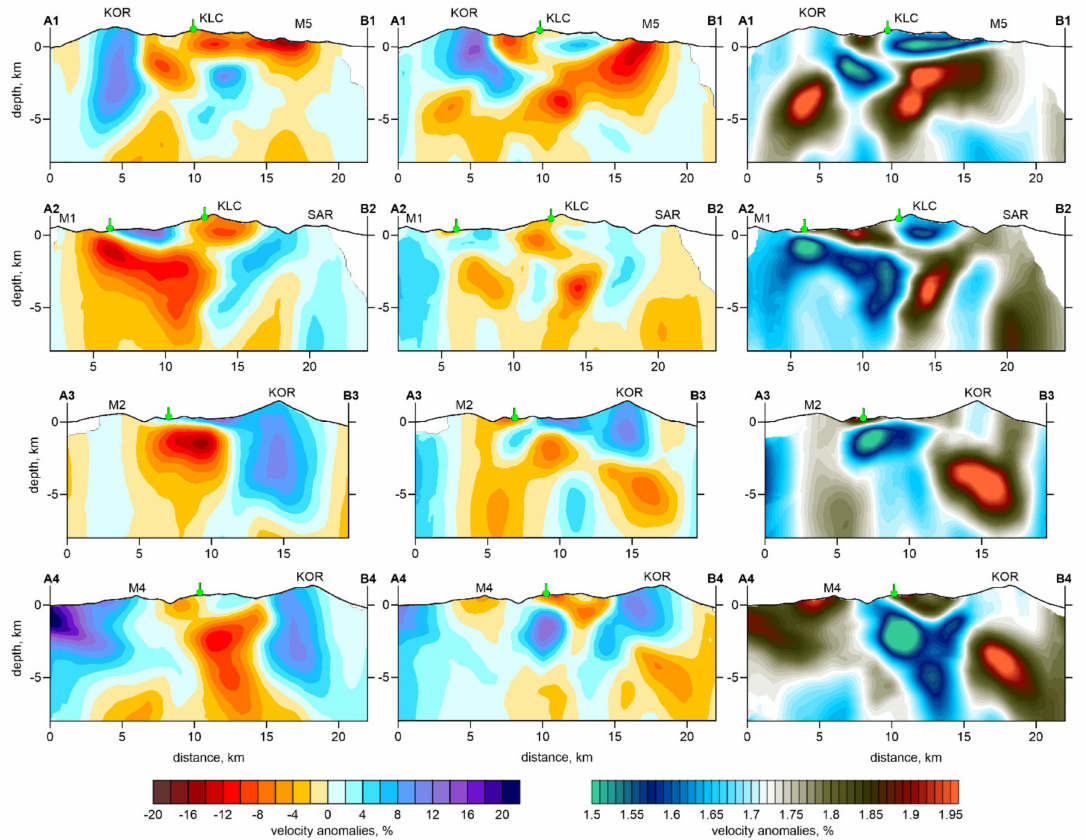
Figure 6. The resulting distributions of the dVp, dVs and Vp / Vs ratio derived from the inversion of experimental data in four vertical sections. Green symbols indicate the locations of geothermal fields. Figure